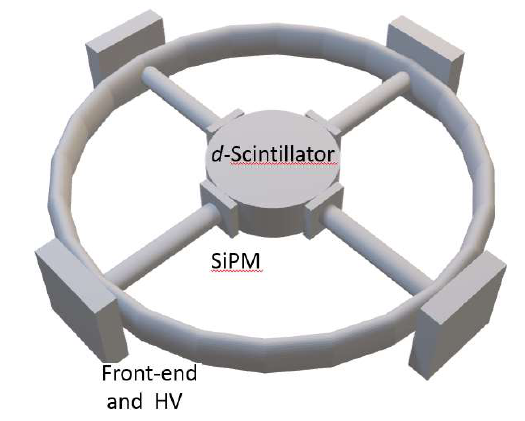
Fig. 6. The geometry of “TaraT”, the Active Target.